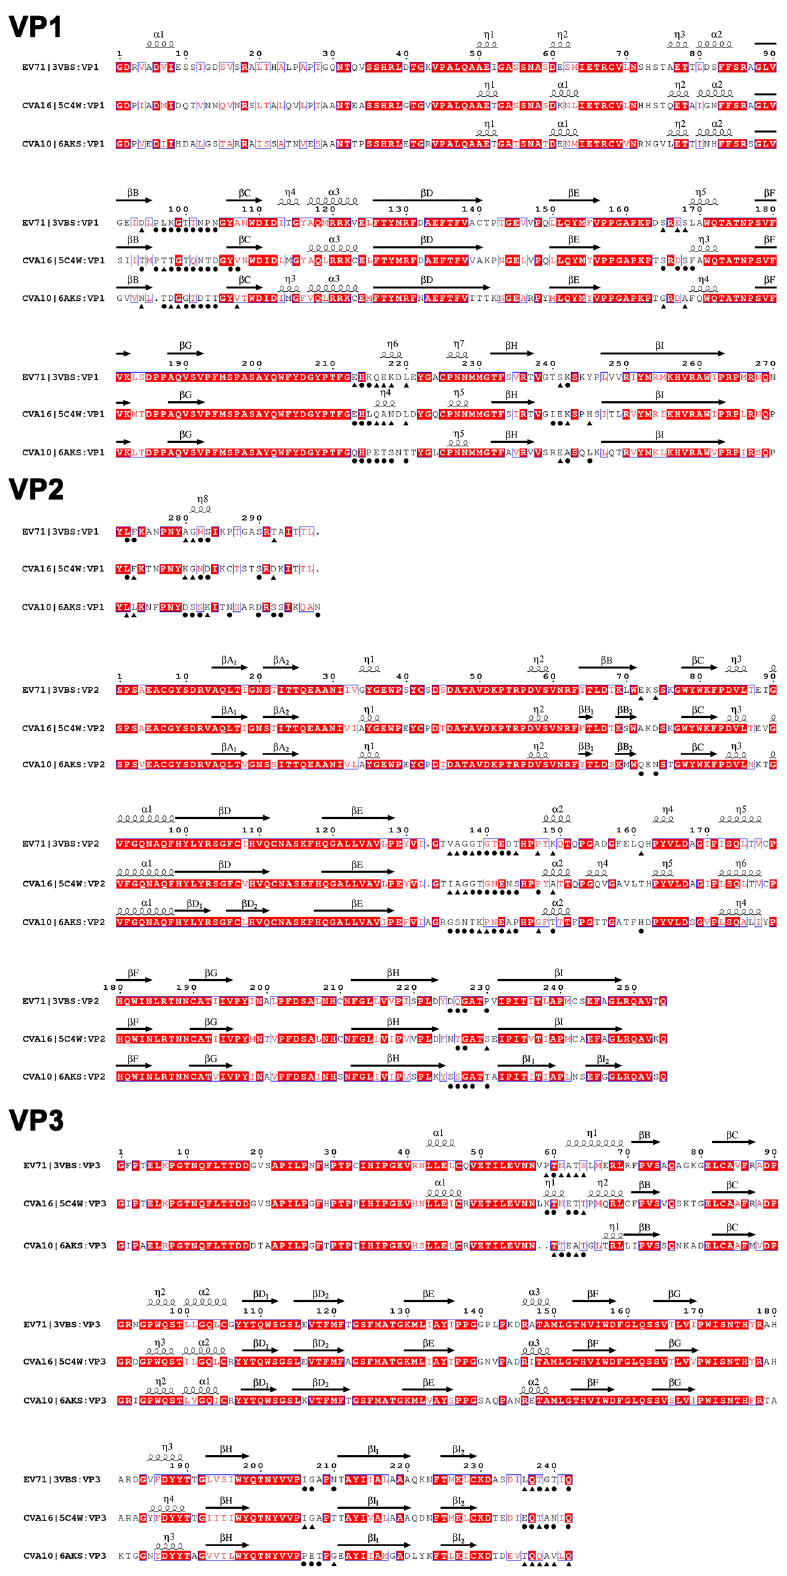
Figure 2. Sequence alignments of three VPs (VP1, VP2 and VP3) of EV-A71, CV-A16 and CV-A10. ESPript representation of structure-based sequence alignments of EV-A71 (GenBank accession no: EU703812), CV-A16 (GenBank accession no: JQ354992) and CV-A10 (GenBank accession no: KP009574) are shown. The second structure elements (β-sheets and α-helices) are shown above the corresponding alignment as arrows (β-sheets) and spirals (α-helices), respectively. The predicted epitopes are shown as black circles (core epitopes) and triangles (surrounding epitopes). The predicted results of CV-A10 are from our previous work. The alignments are colored according to the sequence identity among EV-A71, CV-A16 and CV-A10, on a scale of white (no identity) to red (full